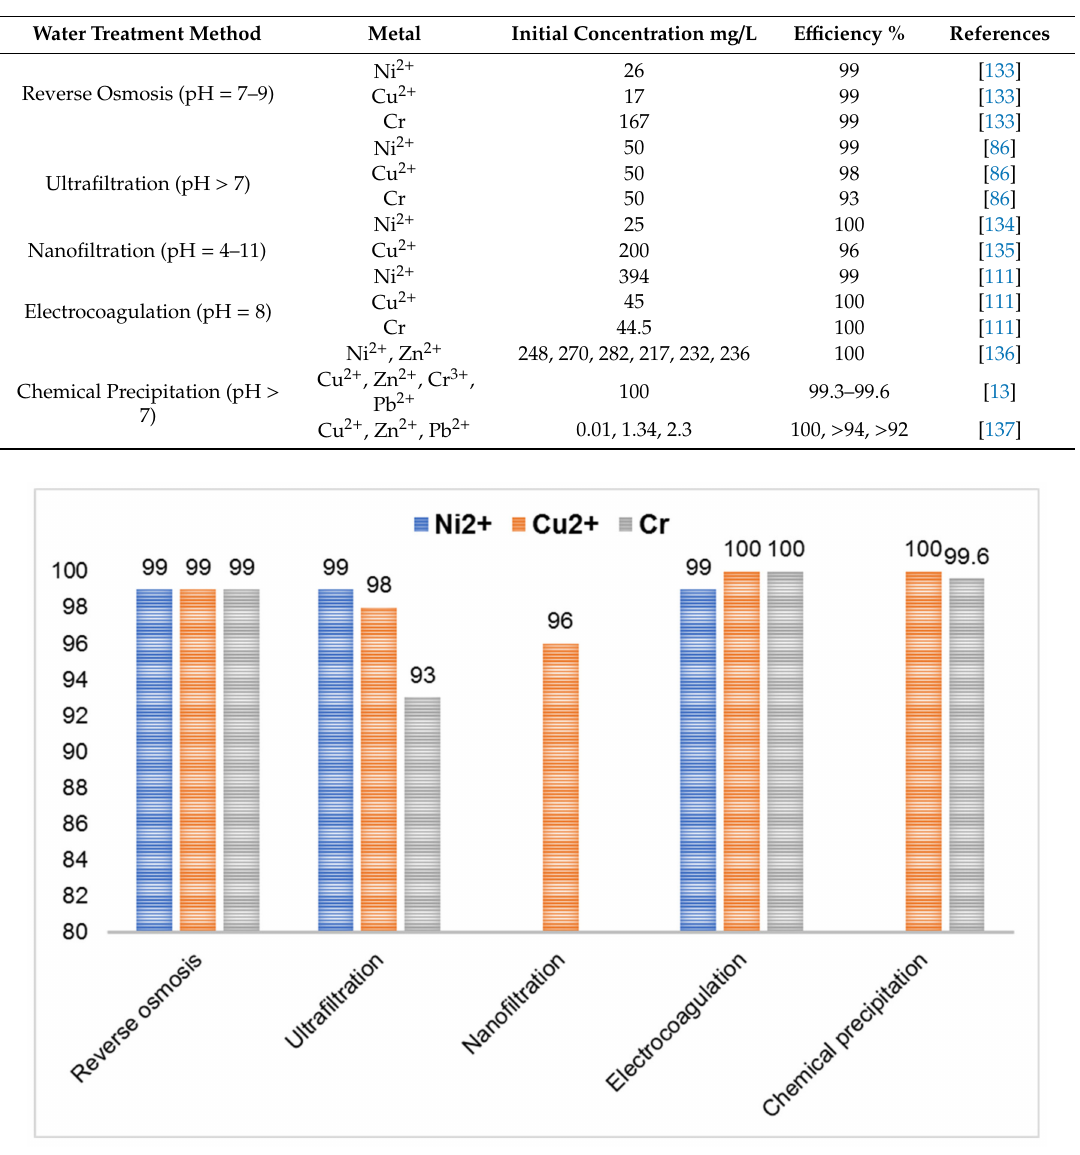
Figure 5. Level of removal e ffi ciency for Ni 2 + , Cu 2 + and Cr as a function of the method of their removal (adapted from